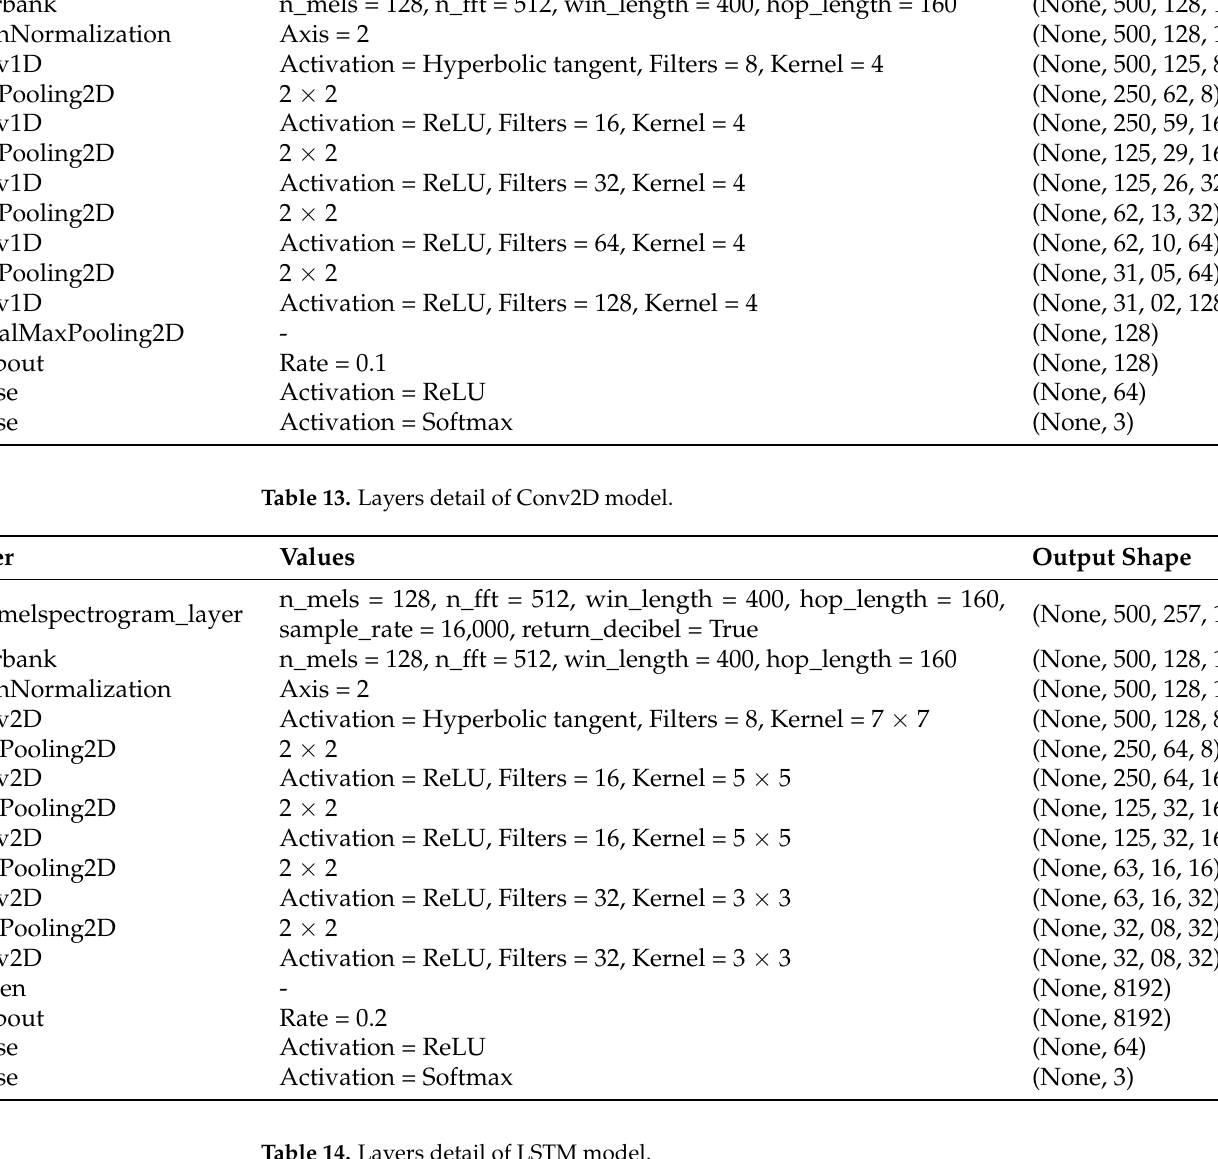
Table 14. Layers detail of LSTM